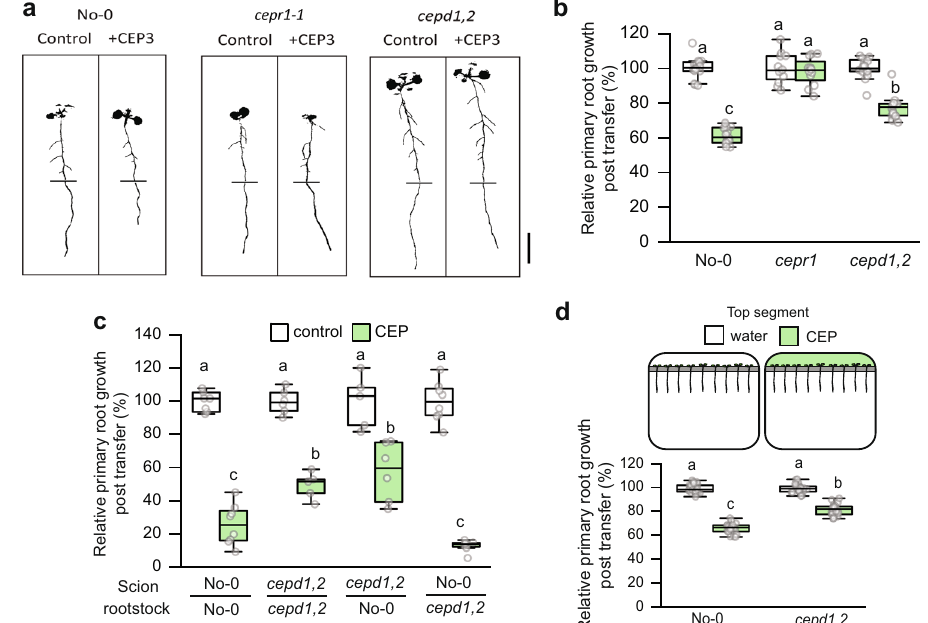
Fig. 6 | CEP signalling through shoot CEPDs inhibits primary root growth. a Representativeimagesand( b )relativeprimaryrootgrowthforNo-0, cepr1-1 ,and the cepd1,2 double mutant seedlings 3 days after transfer to medium with or withoutCEP3(10 − 6 M)( n =12 – 18plants).Horizontalbarsin( a )indicatethelengthof the primary root on the day of transfer (i.e. 6 days growth). Root growth post transfer expressed as a percentage of seedlings grown on medium without CEP3 (control) for each respective genotype. c CEP3 sensitivity of reciprocal hypocotyl grafts between No-0 and cepd1,2 . Root growth 3 days post transfer to treatment plates expressed as a percentage of seedlings grown on medium without CEP3 (control) for each respective graft combination ( n =5 – 8 plants). d A diagrammatic representation (upper) and relative primary root growth (lower) for No-0 and